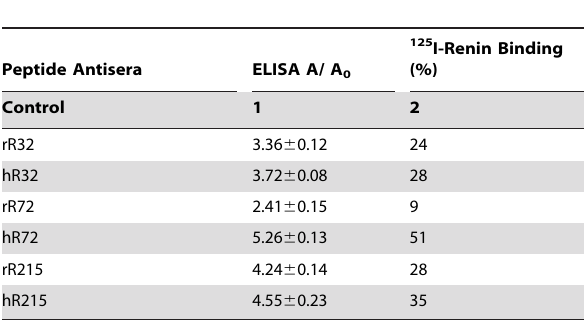
low cross-reactivity (Table 2).